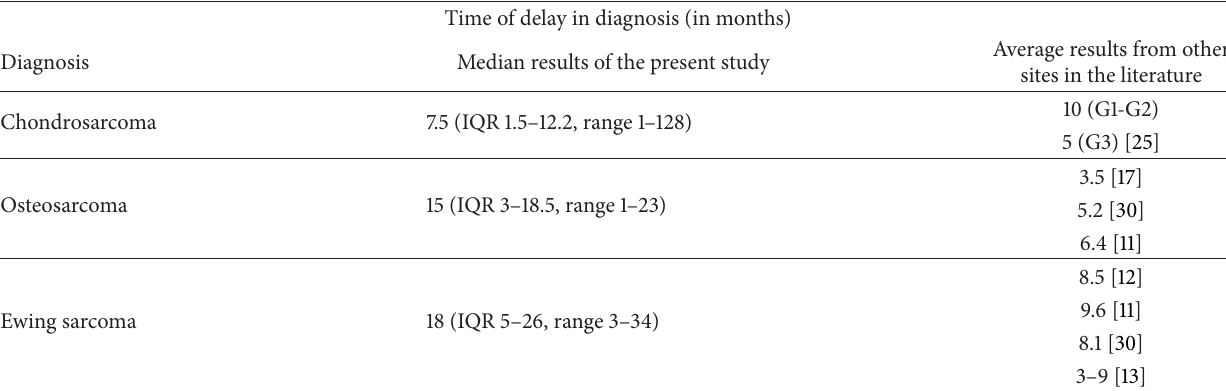
Table 2: Delay in diagnosis at the foot (the present study) and at the other sites (the literature). Time of delay in diagnosis (in months)